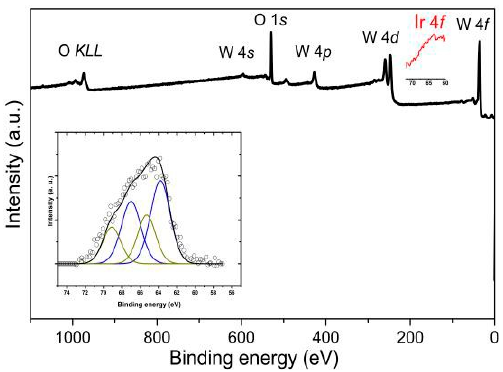
Figure 2. XPS results confirming the presence of iridium and its oxidation